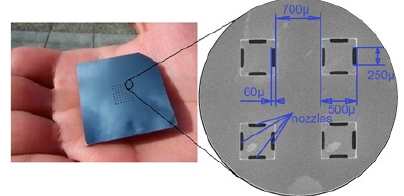
Figure 2. Top side of the titled air jet array.